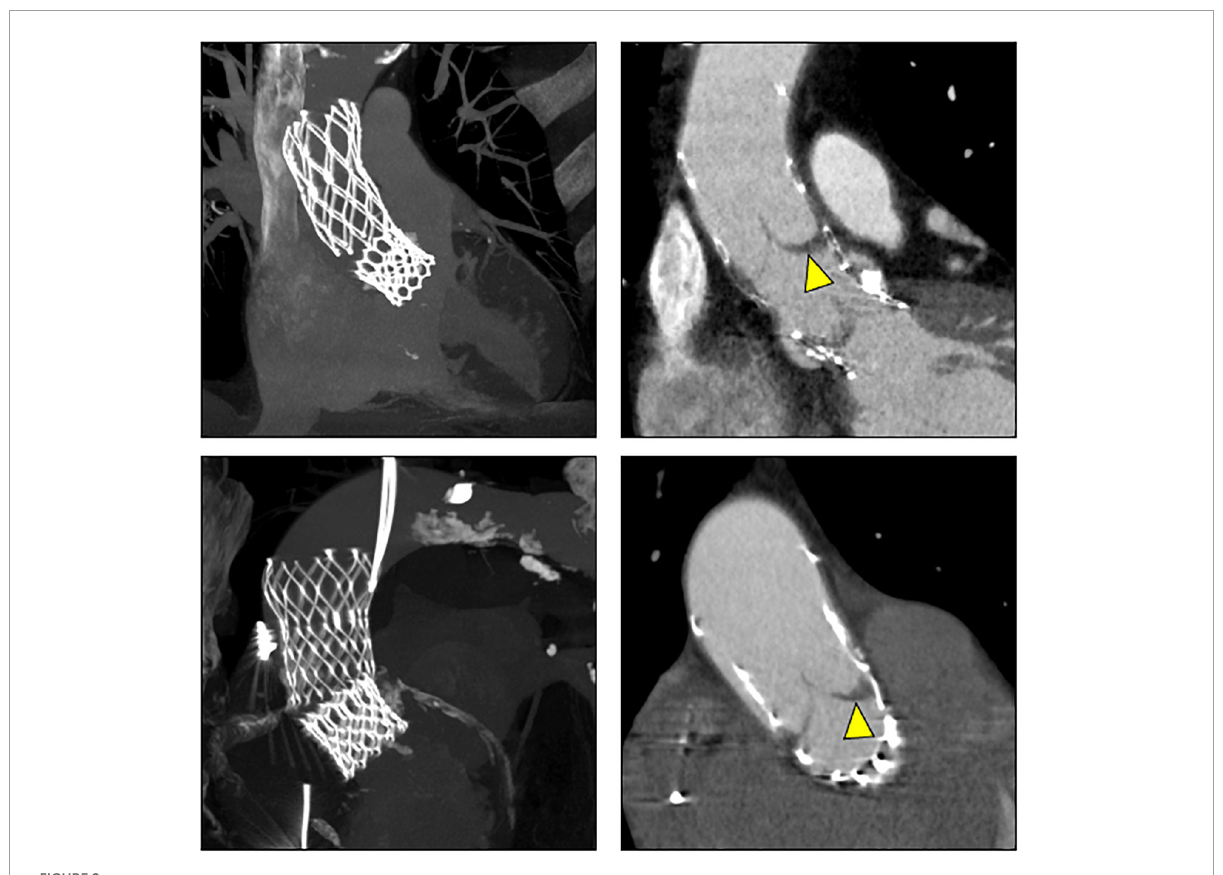
FIGURE2 Subclinical valve thrombosis in embolized valves. In patients 9 (top) and 10 (bottom; see Table 5 for details), follow-up CT detected hypoattenuated leaflet thickening (arrow heads) in self-expanding valves embolized into the ascending